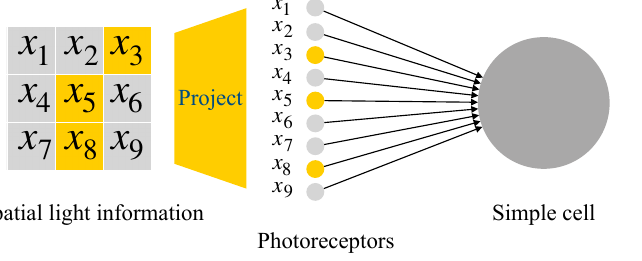
Figure 6. Signal transmission flow from light information to a simple cell. In a 3 × 3 region, the locations of each pixel are labeled from x 1 to x 9 .